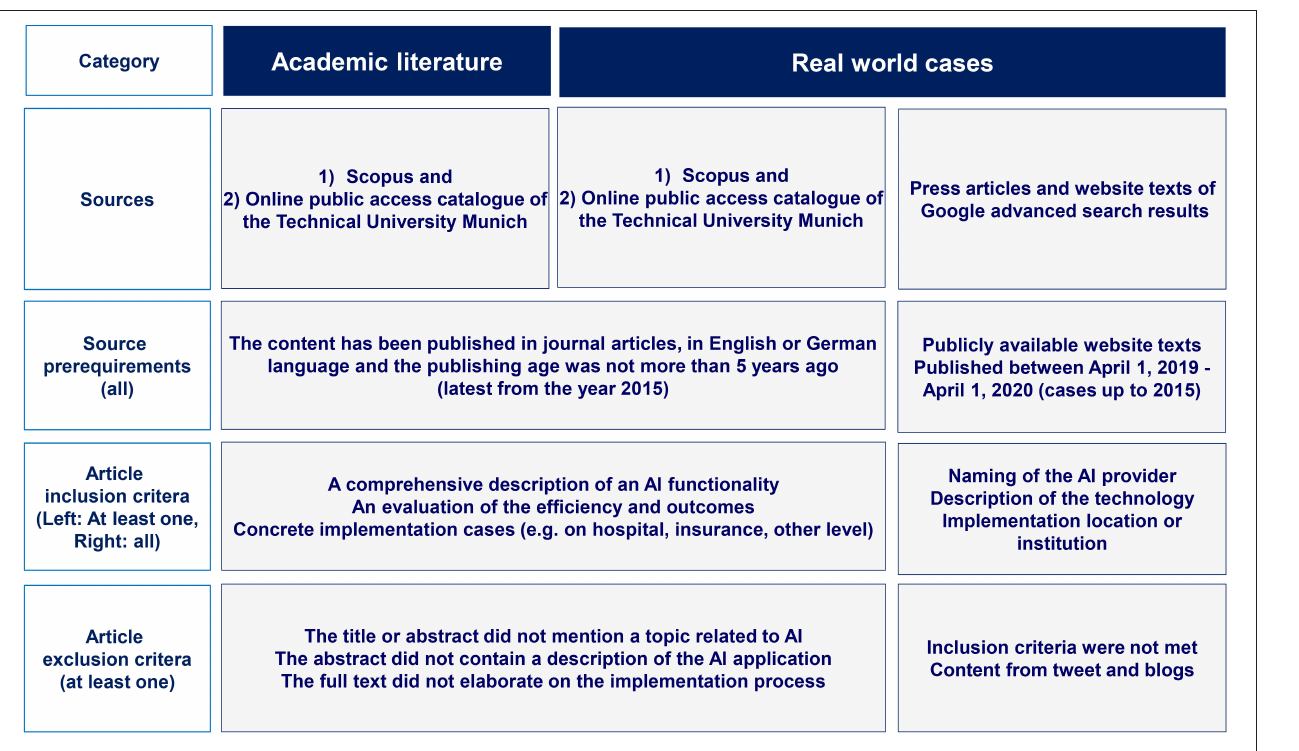
FIGURE 2 | Methodology for the identification of academic literature and real-world AI application cases in healthcare